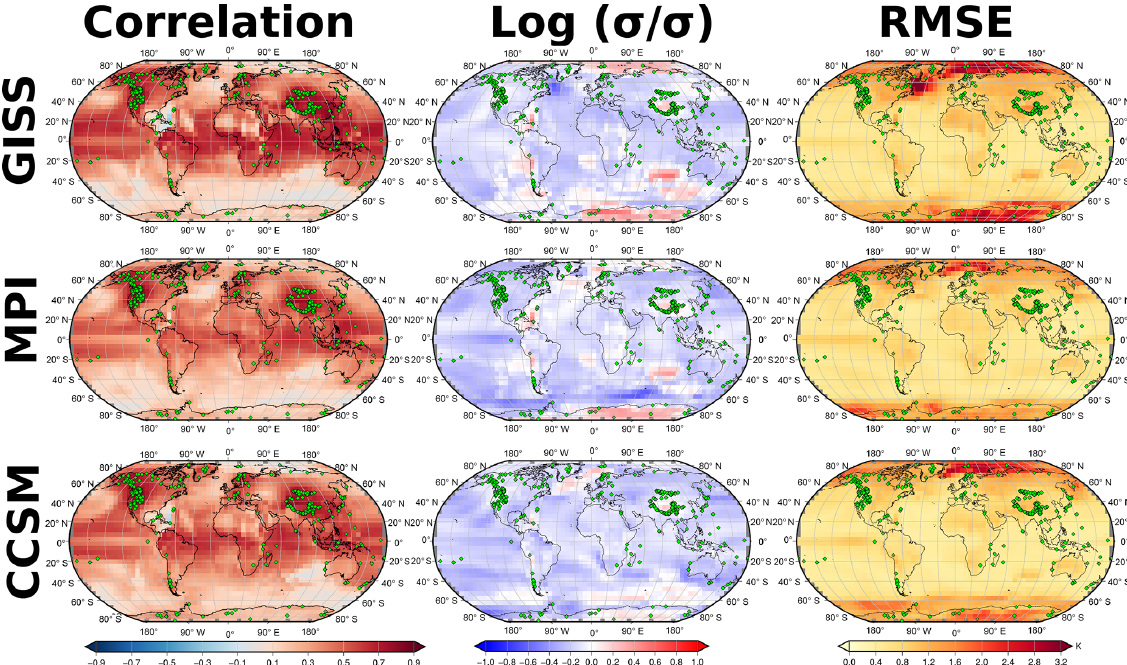
Figure 7. Correlation (left), logarithm of the ratio of the standard deviations (middle), and RMSE (right) between the target SAT and the pseudo-reconstructed SAT based on a PPE with additive white noise as in Sect. 4.2. All reconstructions use the same AM setup based on searching analogues that minimises RMSE and then averaging the five closest analogues. The only difference across rows is the model used as a target for the PPE: GISS (top map, equivalent to Fig. 5), MPI-ESM-P (middle), and CESM4